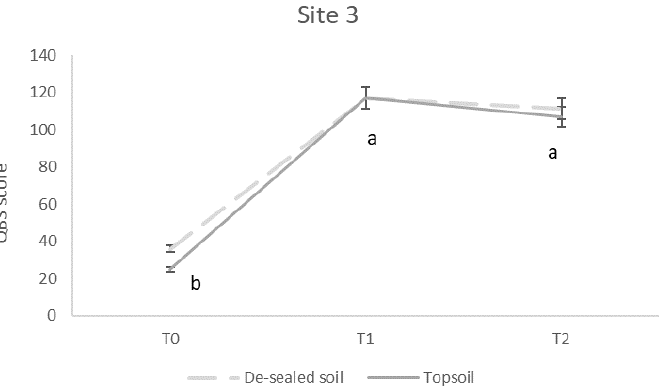
Figure 4. Total score for Soil Biological Quality index (QBS-ar) in de-sealed and topsoil plots for each site at three sampling points (T0, T1 and T2). Significant differences between de-sealed and topsoil (at least p < 0.05) within the same time are shown by asterisks (** < 0.01); small letters denote a comparison across time for de-sealed soil and topsoil.